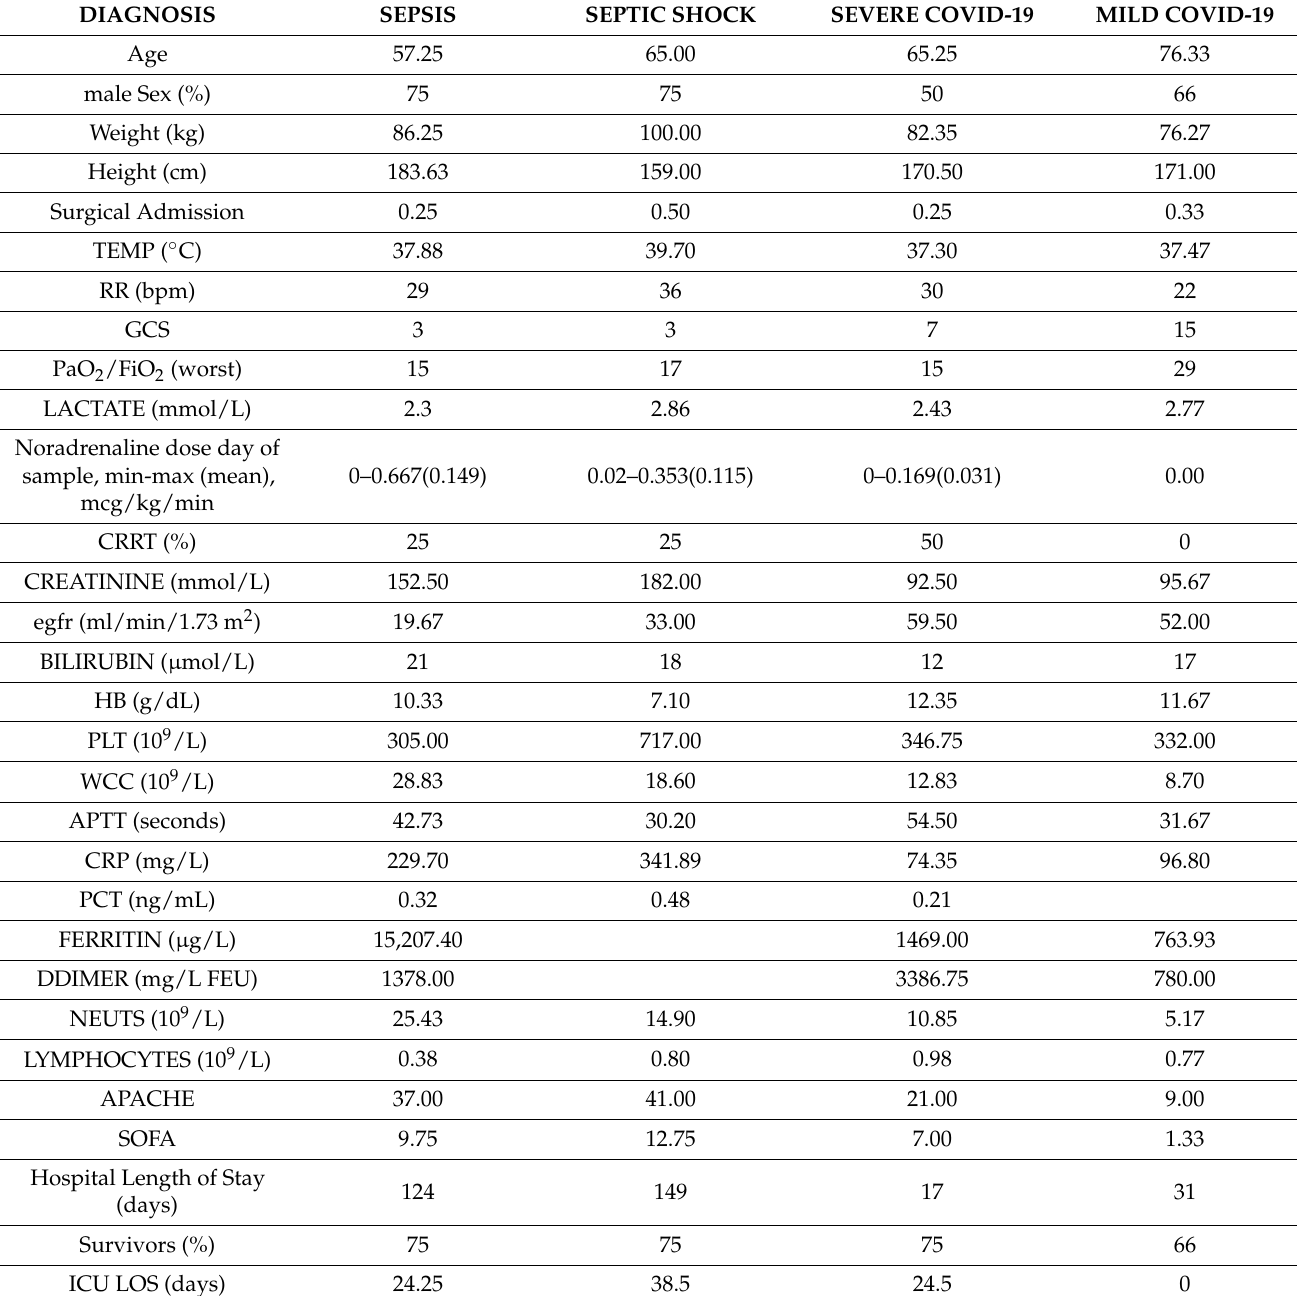
Table 1. Patient clinical characteristics and